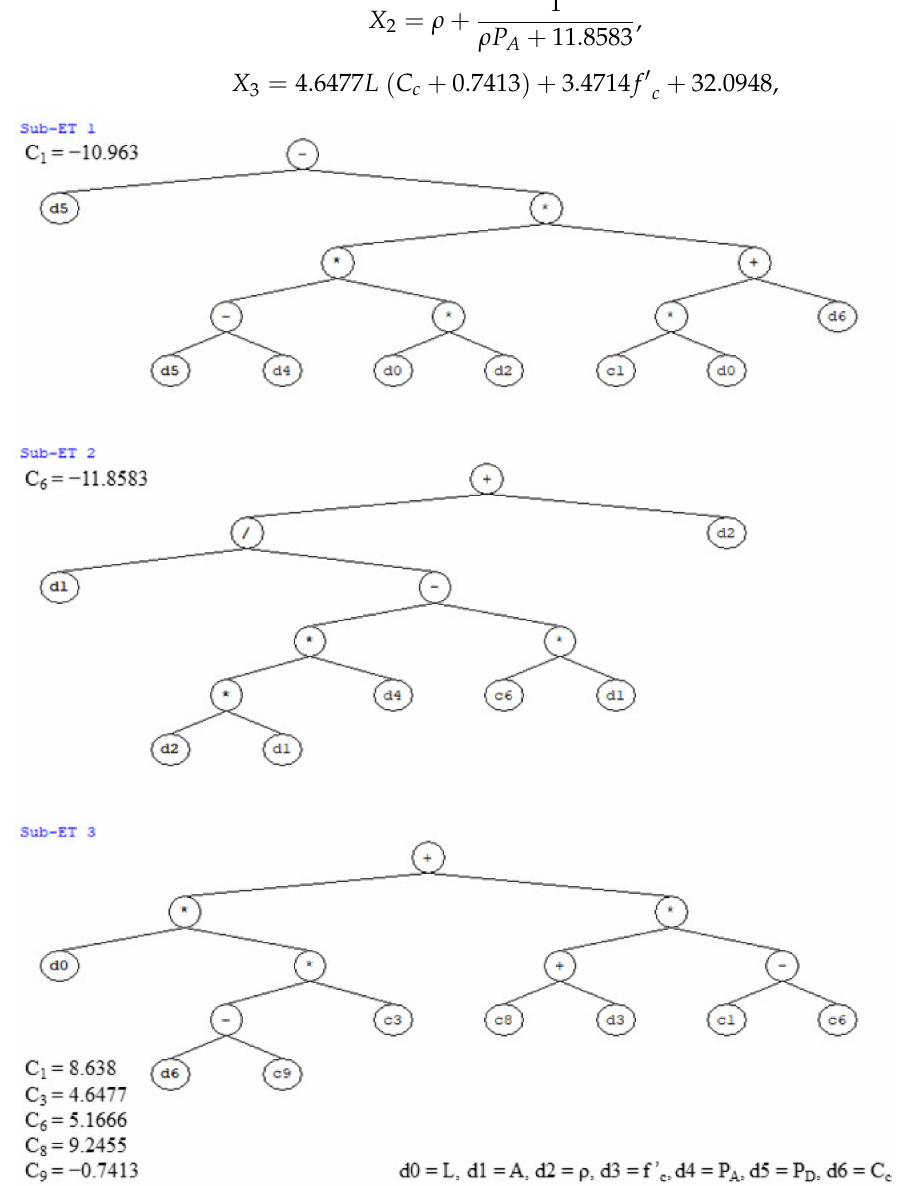
Figure 3. GEP Expression Tree for Flexural Capacity